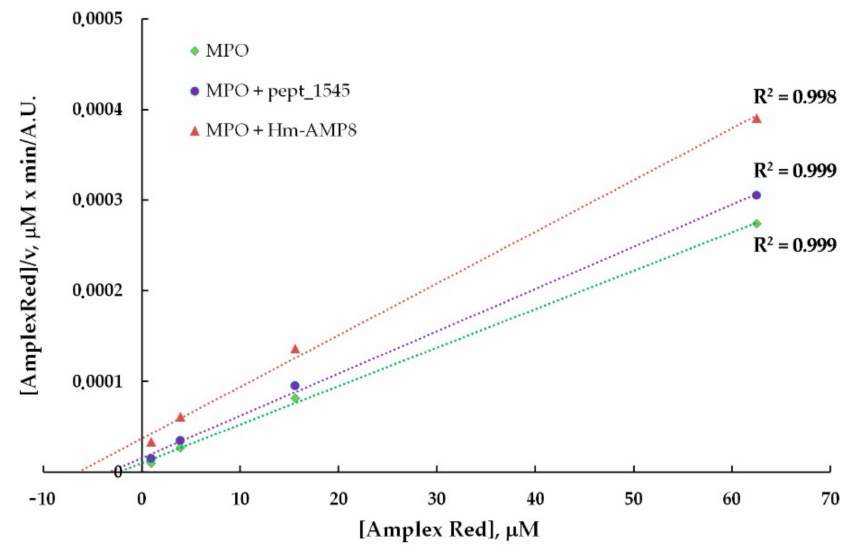
Figure 7. Hanes–Woolf plot illustrating the effect of 20 µ M pept_1545 and 2 µ M Hm-AMP8 on kinetics of MPO-catalyzed reaction of H 2 O 2 with Amplex Red ( n = 3). The concentrations were as follows: 8 nM MPO heme, 25 µ M H 2 O 2 , and 1 µ M– 62.5 µ M Amplex Red in 50 mM K-phosphate buffer, pH